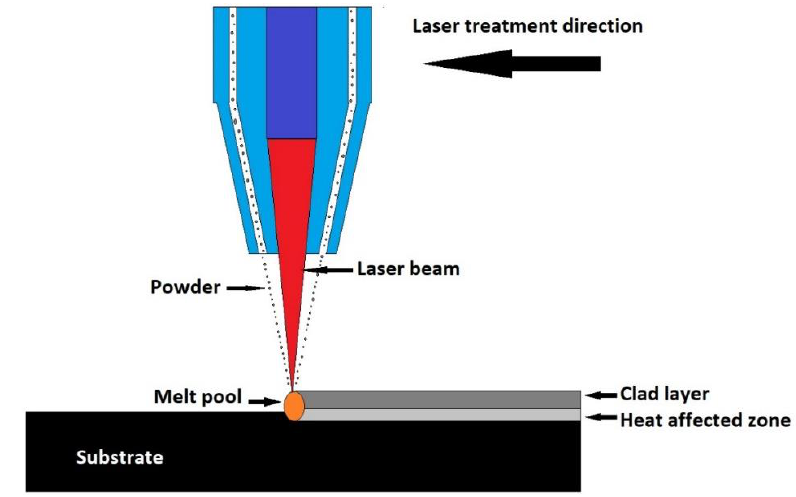
Figure 5. Schematic representation of laser cladding technique.